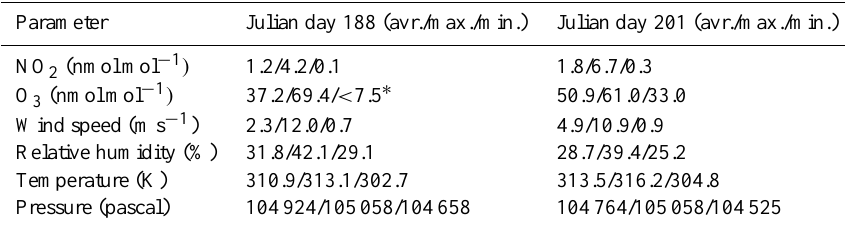
Table 1. Photochemical and meteorological ambient conditions. Several measured chemical and meteorological average (avr.), maximal (max.) and minimal (min.) values that were obtained during daytime (06:00–20:00LT) are presented for Julian days 188 and